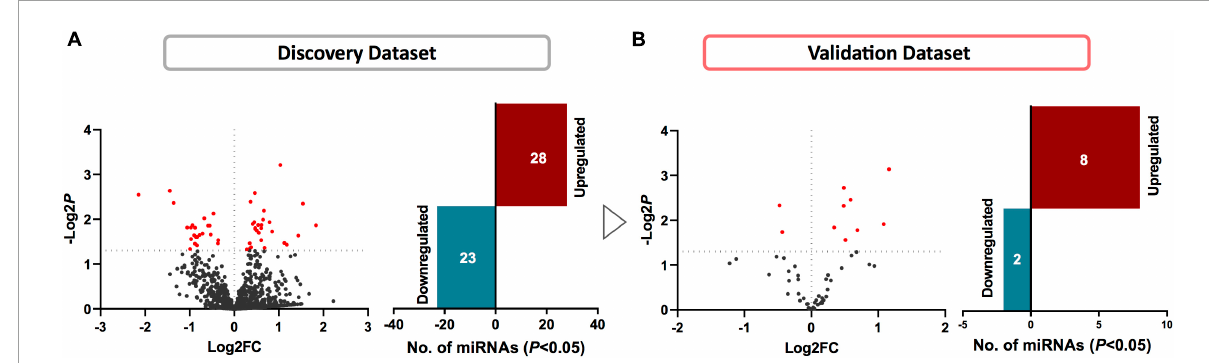
FIGURE2 Identifying differentially regulated miRNAs in SWDM compared to SWoDM patients. Volcano plots show the number of differentially regulated miRNAs in SWDM versus SWoDM patients: red dots depict statistically significant ( P < 0.05) and gray dots depict unsignificant miRNAs, while bar plots show the number of statistically significant miRNAs: downregulated in teal and upregulated presented in crimson color in (A) discovery and (B) validation datasets.